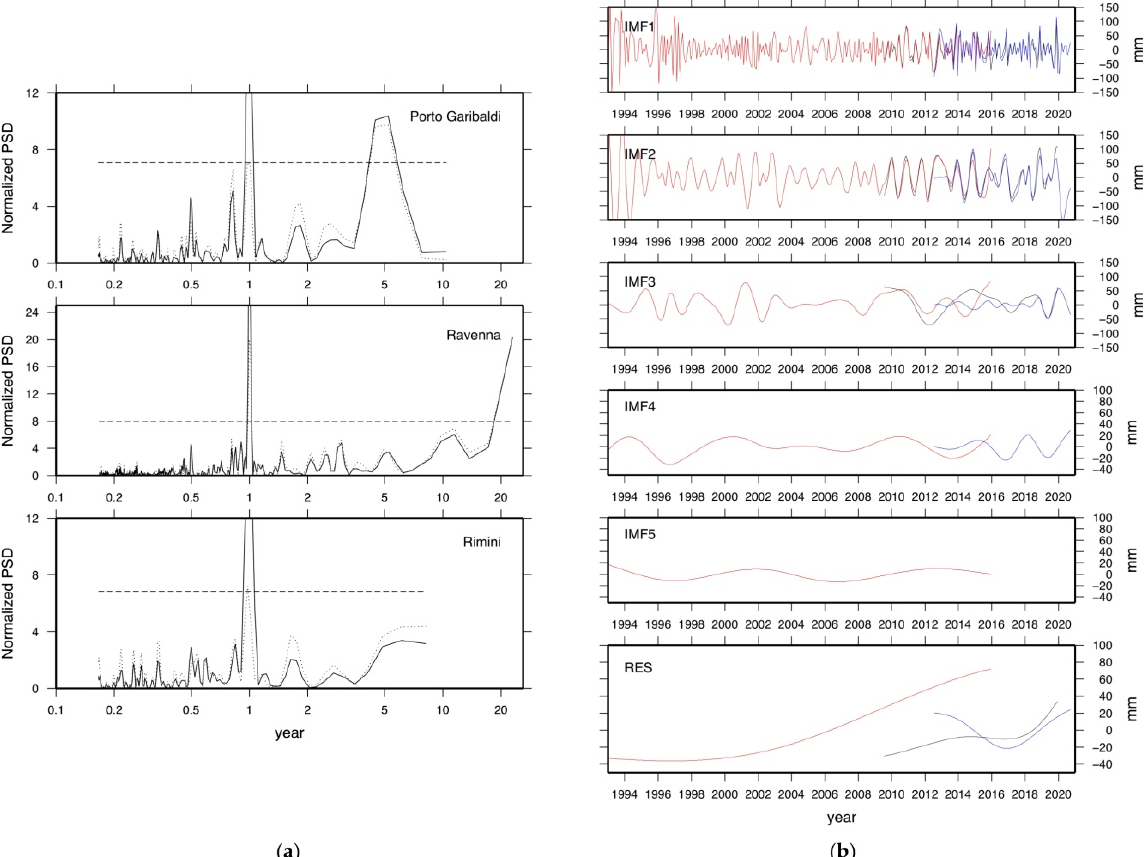
Figure 4. ( a ) Normalized power spectral density (PSD) periodogram resulting from the LSP analysis for TG PG , TG RA , TG RN time series. In each frame, the dotted line represents the periodogram for raw data while the solid line is the periodogram for IB-corrected time series. The dashed horizontal line represents the significance (90%); ( b ) EMD for IB-corrected data. Red for Ravenna, black for Porto Garibaldi, and blue for Rimini. The Y axis of the two bottom frames have been enlarged to better visualize the small amplitude signals.